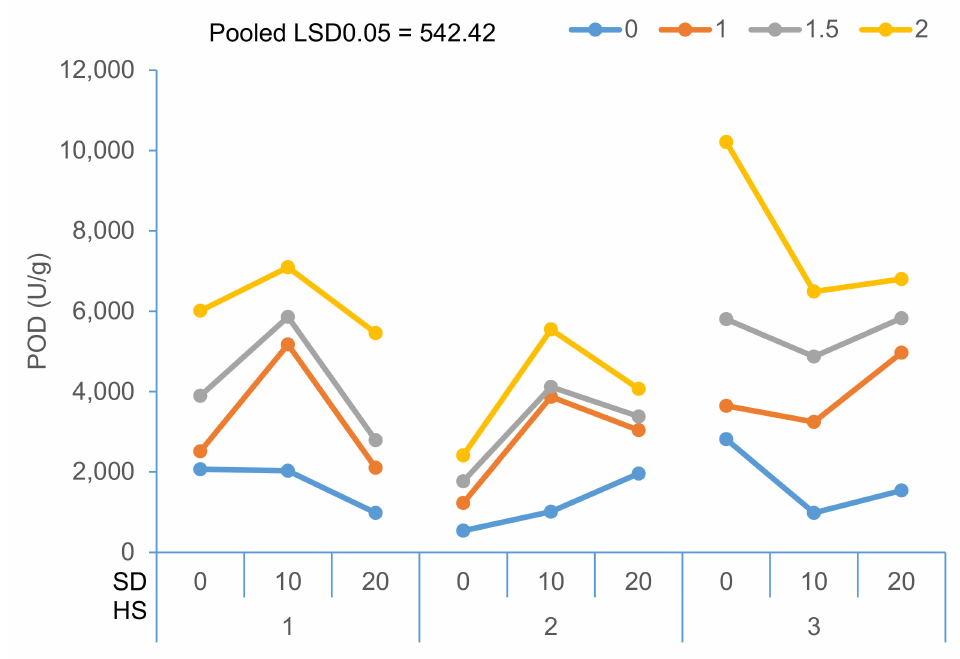
Figure 10. The interaction effects of CaCl 2 (0, 1, 1.5, and 2%, w / v ), harvesting stages (HS: 1 = green mature, 2 = breaker and 3 = half-ripe), and storage durations (SD: 0, 10 and 20 days) on POD enzyme activity (unit) of MT-3 tomato fruit stored at ambient temperature (28 ± 2 ◦ C and 75 ± 5% RH). Pooled LSD 0.05 = 542.42.